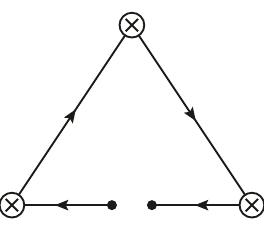
Figure 4. Feynman diagram of the quark condensate contribution to the three-point Green func- tions at the leading order O